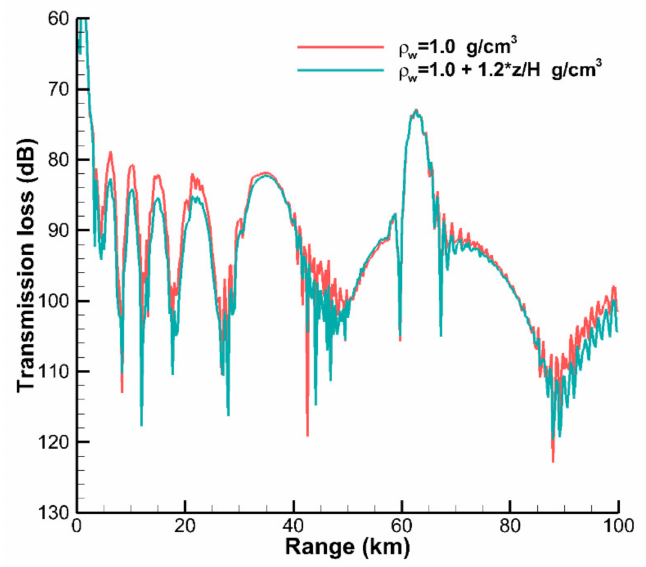
Figure 13. TL curves along z = 100 m for the Munk waveguide (4th-order